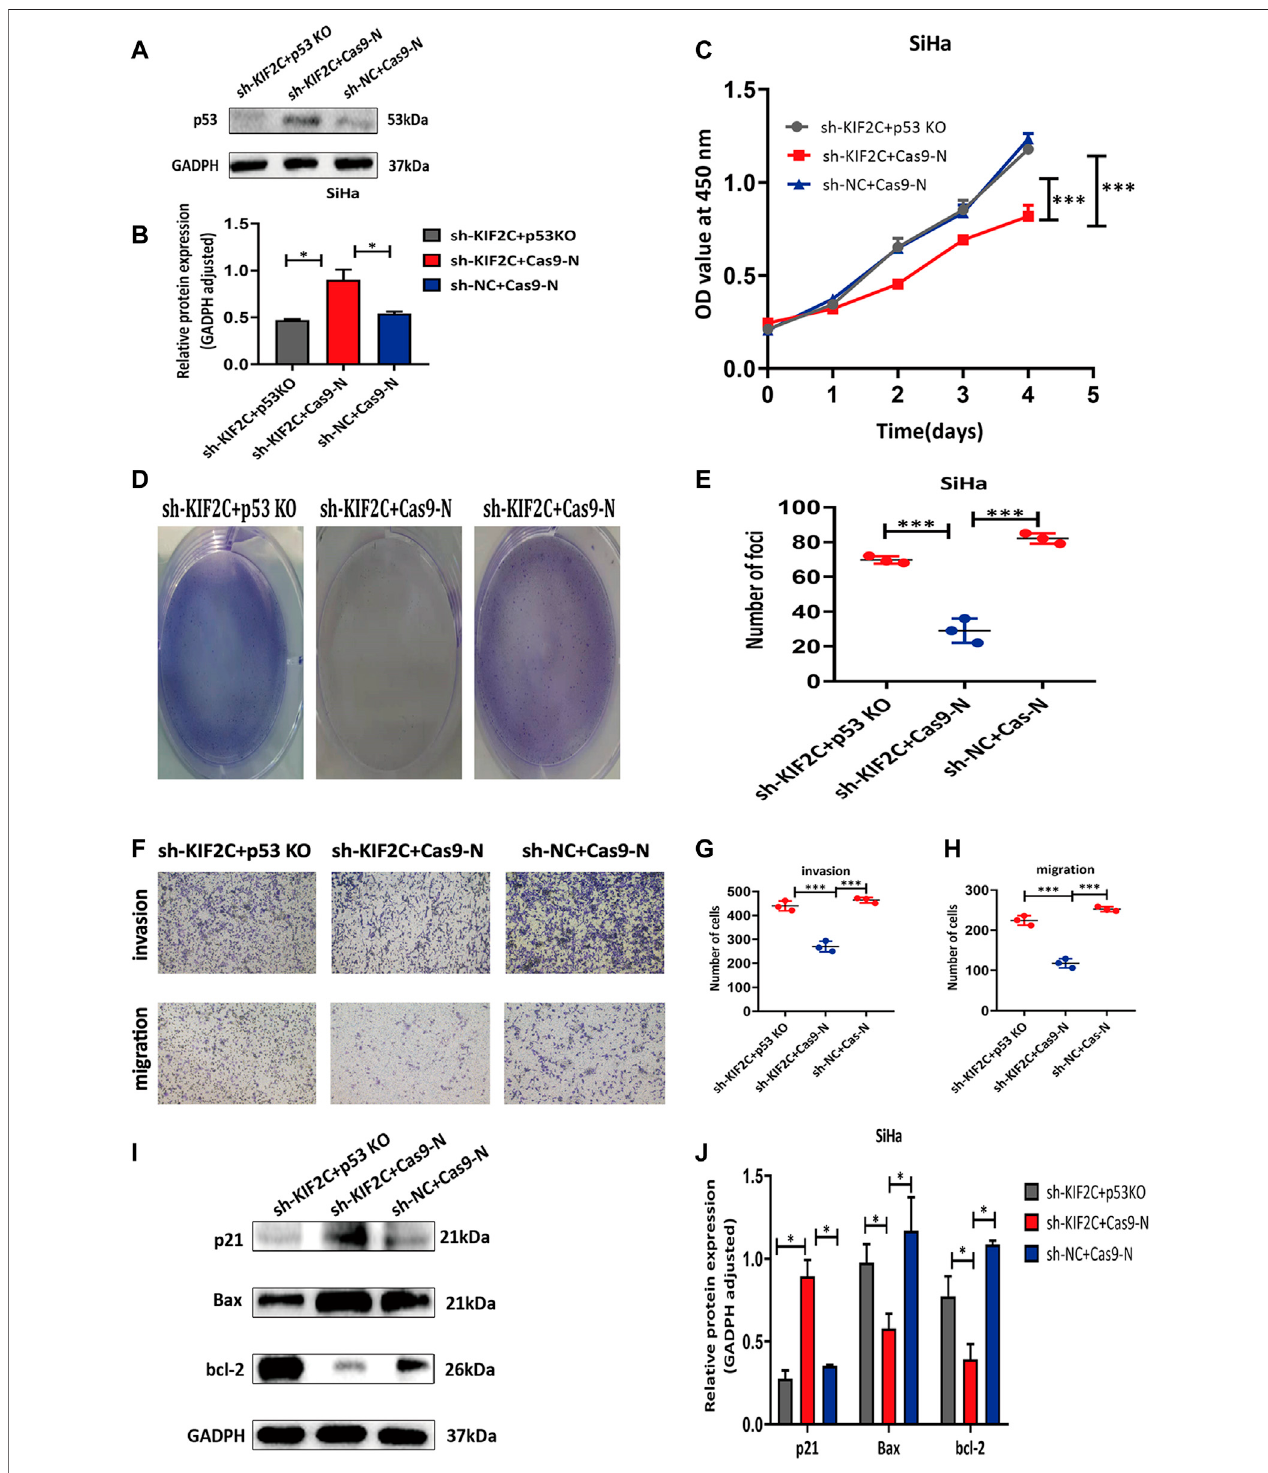
FIGURE11| p53knockdownrescuedinhibitoryeffectsofKIF2Cincervicalcancer. (A) Grayvalueofp53proteinbandinSiHaaftertransfection; (B) relativeprotein expression of p53 in SiHa after transfection; knockdown of p53 partially reversed KIF2C induced inhibition of proliferation in SiHa cells determined by CCK-8 assay (C) and colony formation assay (D,E) ; knockdown of p53 partially reversed KIF2C induced suppression of invasion and migration (F) ; bar graphs in (G,H) show results of quantitativeanalyses. (I) Grayvalueofp21,Bax,andbcl-2proteinbandinSiHaaftertransfection; (J) relativeproteinexpressionofp21,bax,andbcl-2inSiHaafter transfection. *p < 0.05; **p < 0.01; ***p < 0.001.